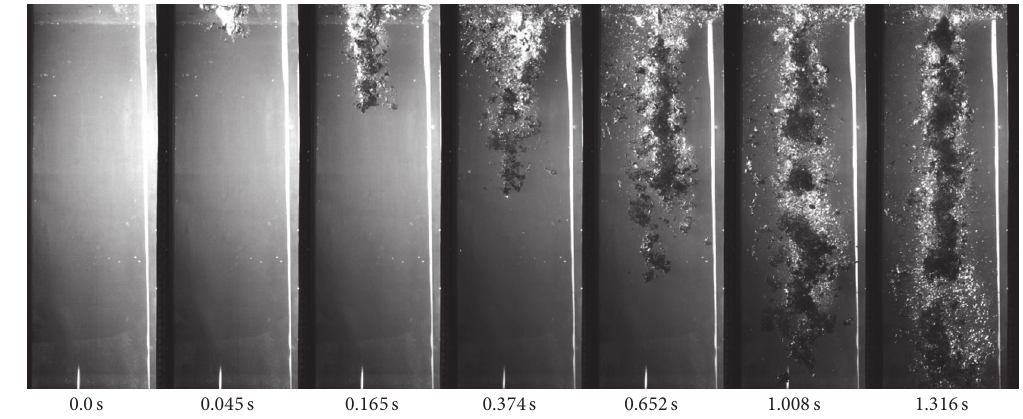
Figure 2: Melt permeating process of test